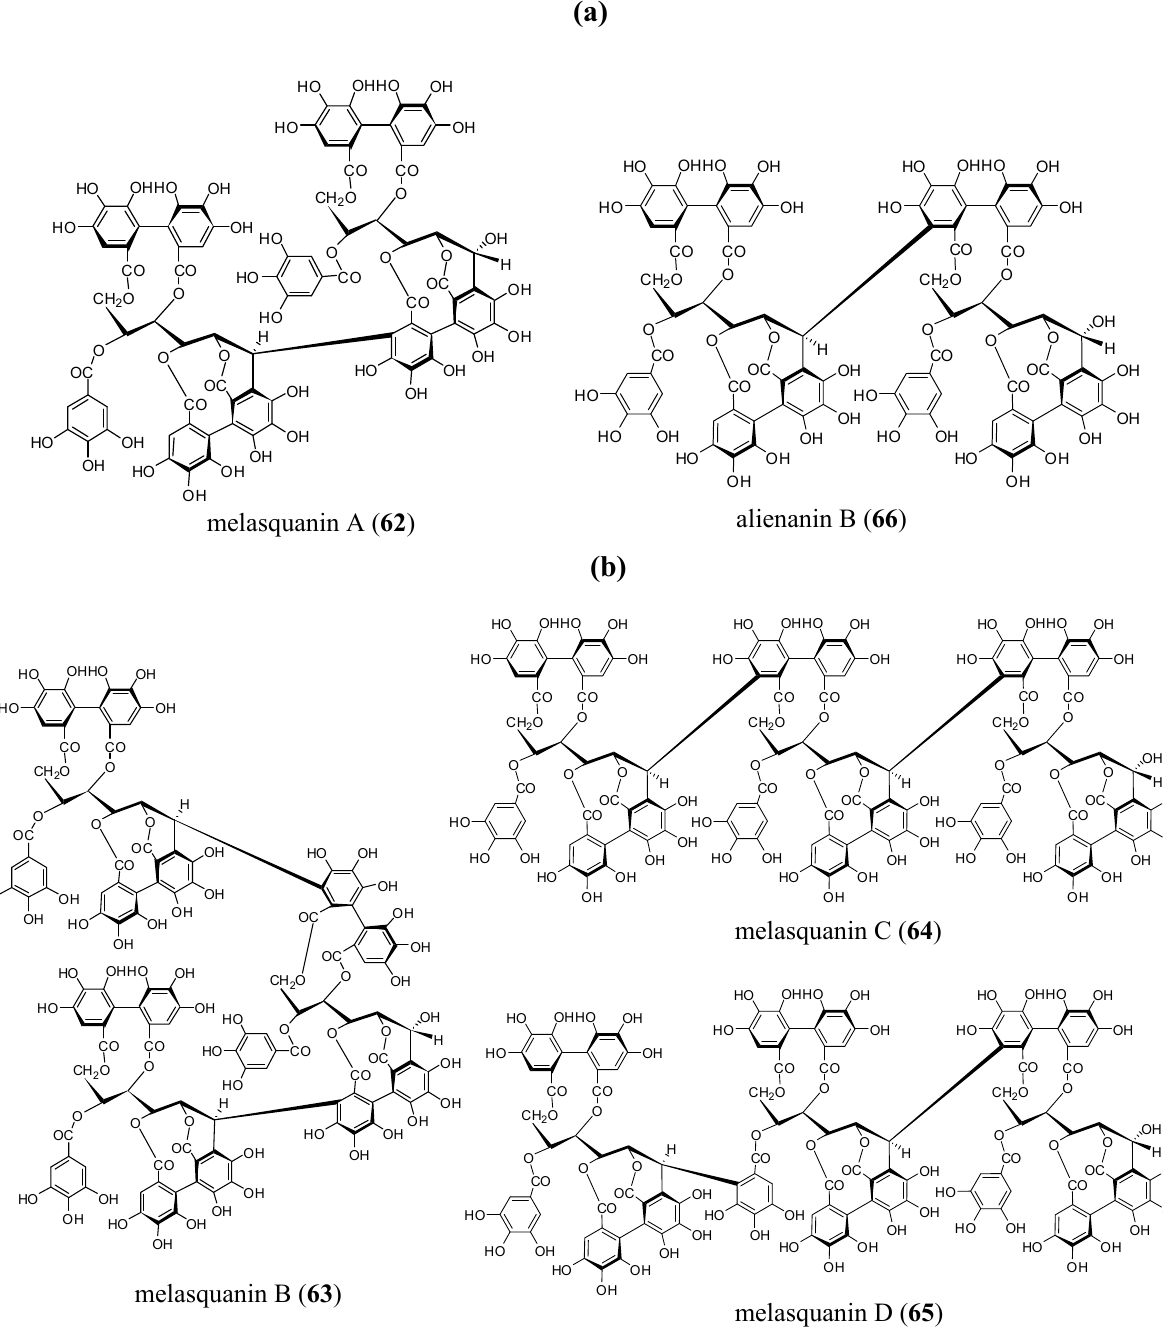
Figure 7. (a) Structures of ellagitannin oligomers 62 and 66 . (b) Structures of ellagitannin oligomers 63 – 65